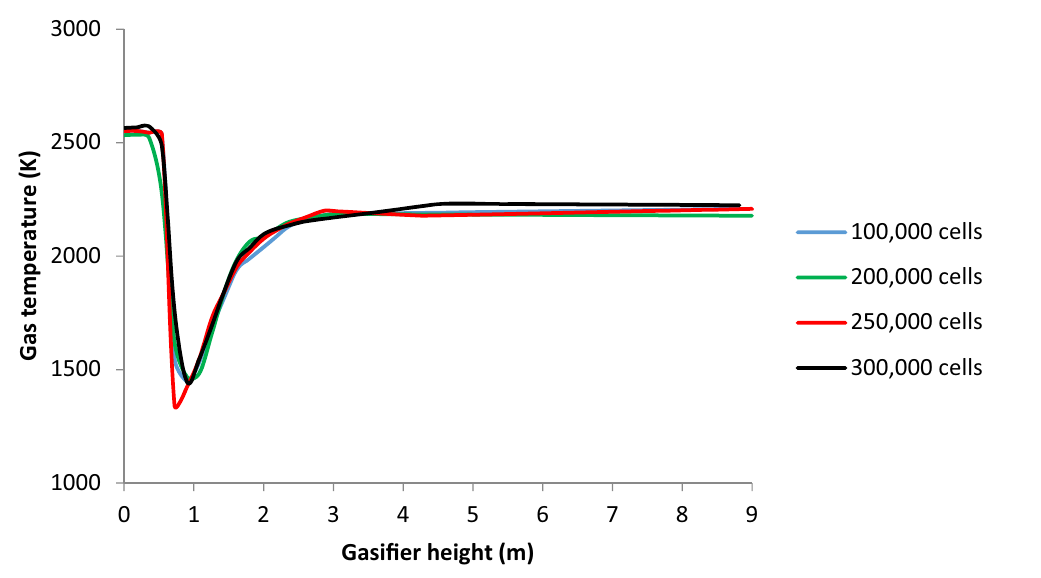
Fig. 4 Temperature distributions for the different grid sizes of the 2-D